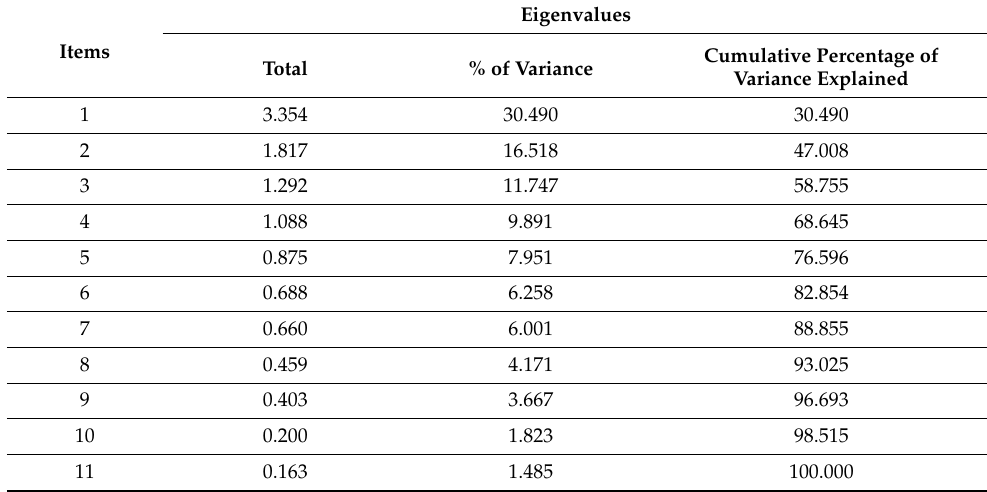
Table 4. Four-factor model of principal component analysis for 11 items.